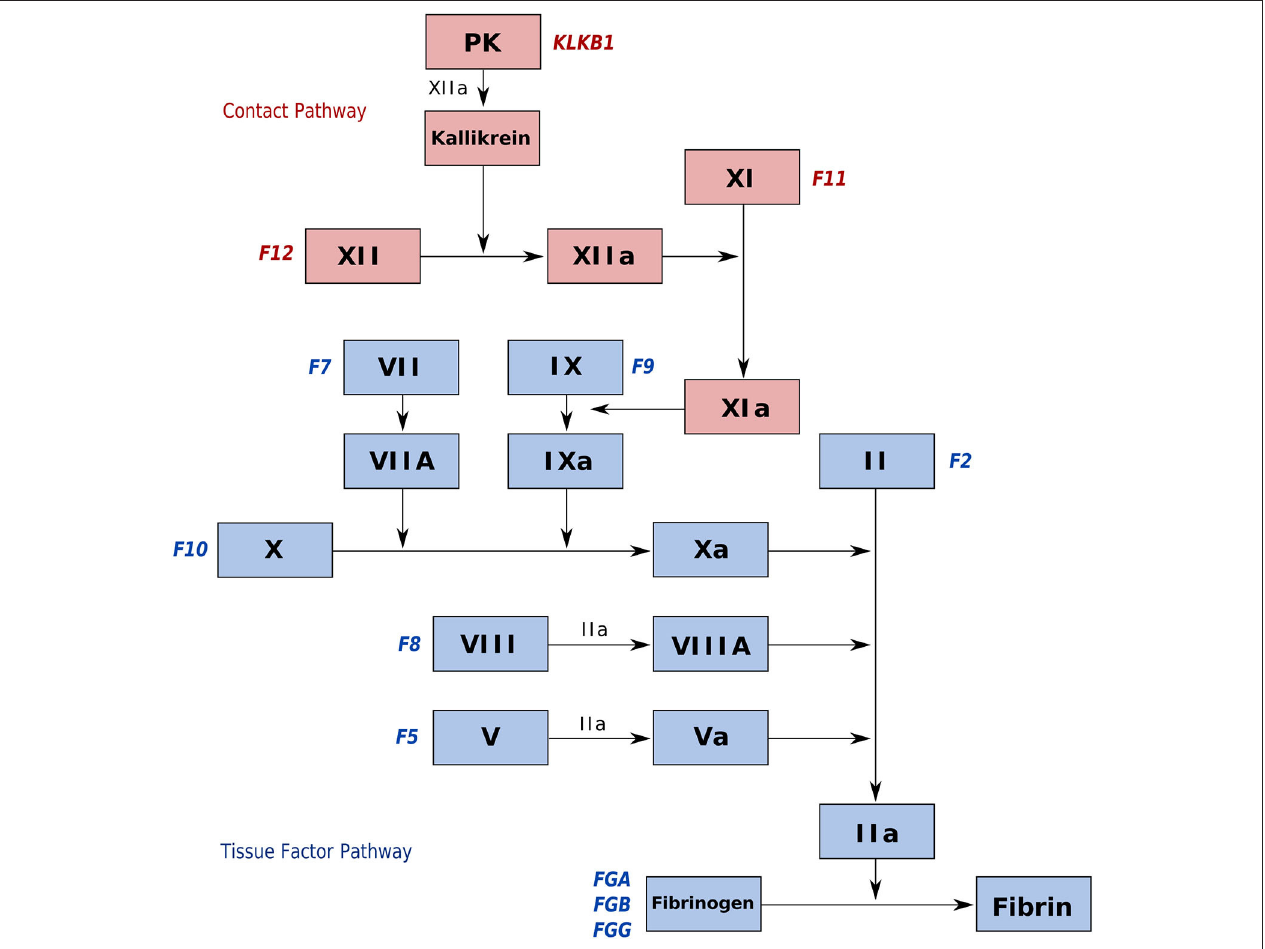
FIGURE 1 | Schematic representation of both blood coagulation pathways: tissue factor pathway (white boxes and blue gene names) and contact pathway (gray boxes and red gene names). The mechanism for both is a cascade of factor activation, ultimately resulting in the activation of a common pathway. This common pathway starts when factor IX is activated, and in turn, activates factor X. Factors are denoted by Roman numbers, whereas the gene names are denoted by Arabic